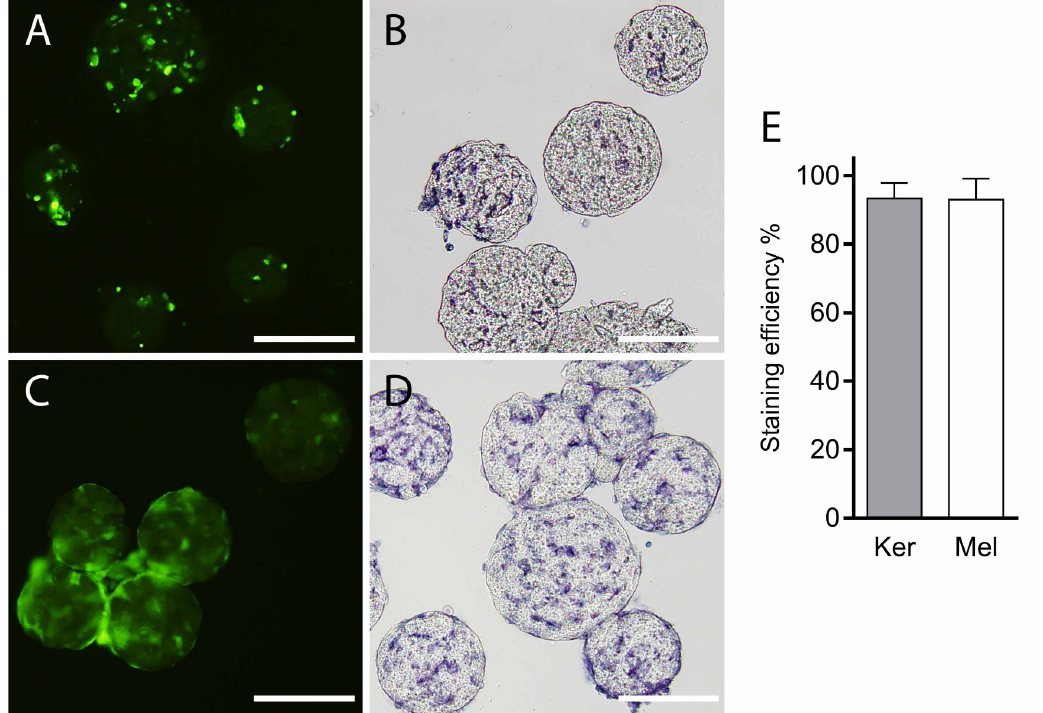
Fig 2. Staining efficiency and microcarrier attachment. (A) Keratinocytes stained with 5 μ M 5(6) carboxyfluorescein-N- hydroxysuccinimidyl ester (CFSE) after 24 hours in spinner flask culture. (B) (4, 5-dimethylthiazol-2-yl)-2, 5-diphenyltetrazolium bromide (MTT)-staining of CFSE-stained keratinocytes on microcarriers after 72 hours in spinner flask culture, indicating viable cells. (C) Melanocytes stained with 5 μ M CFSE after 48 hours in spinner flask culture. Scale bar = 200 μ m (D) MTT-staining of melanocytes on microcarriers after 72 hours in spinner flask culture, indicating viable cells. In both the CFSE and MTT stainings, cells occupying outer surface as well as the inner pores of the microcarriers can be observed. (E) Staining efficiency of 5 μ M CFSE investigated 24 hours after staining; 93.3 ± 2.6% of keratinocytes and 93.0 ± 3.5% of melanocytes were positive for CFSE and nuclear staining (mean ± SD, n = 3). Ker = keratinocytes; Mel = melanocytes. Scale bars = 300 μ